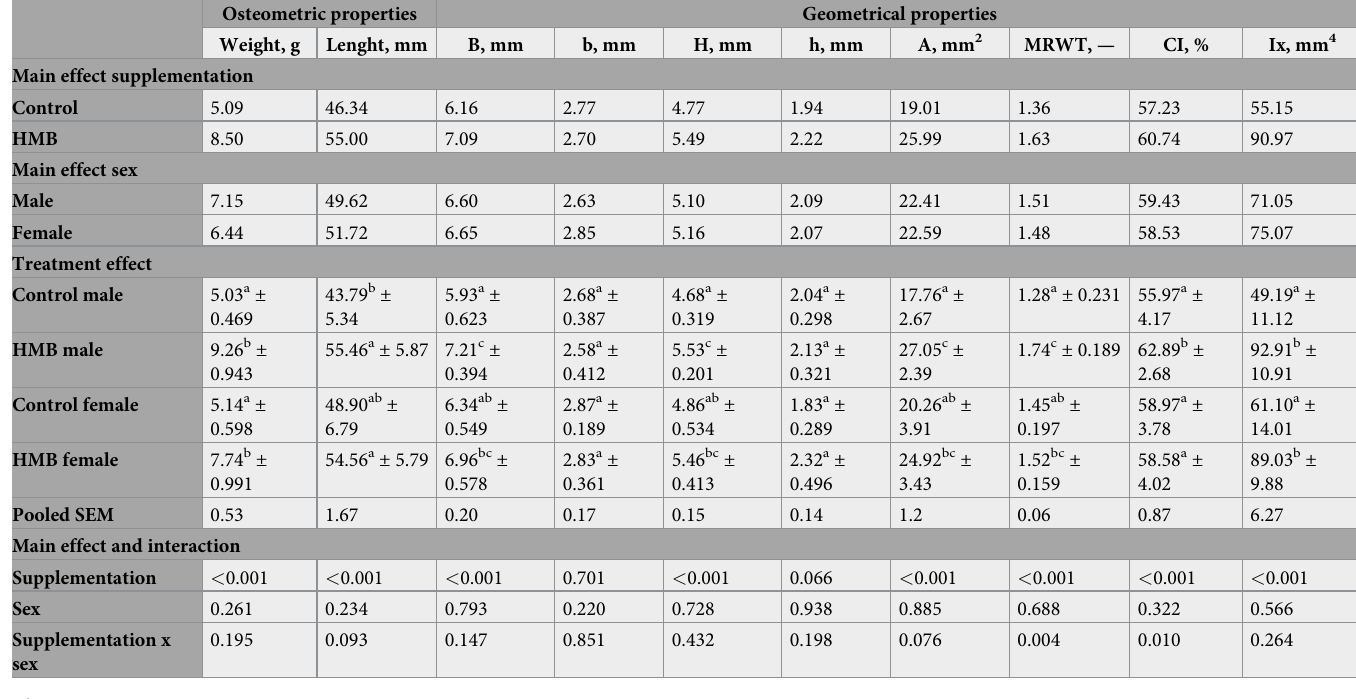
Table 1. The effect of maternal treatment with HMB on the humerus osteometric and geometrical properties in newborn